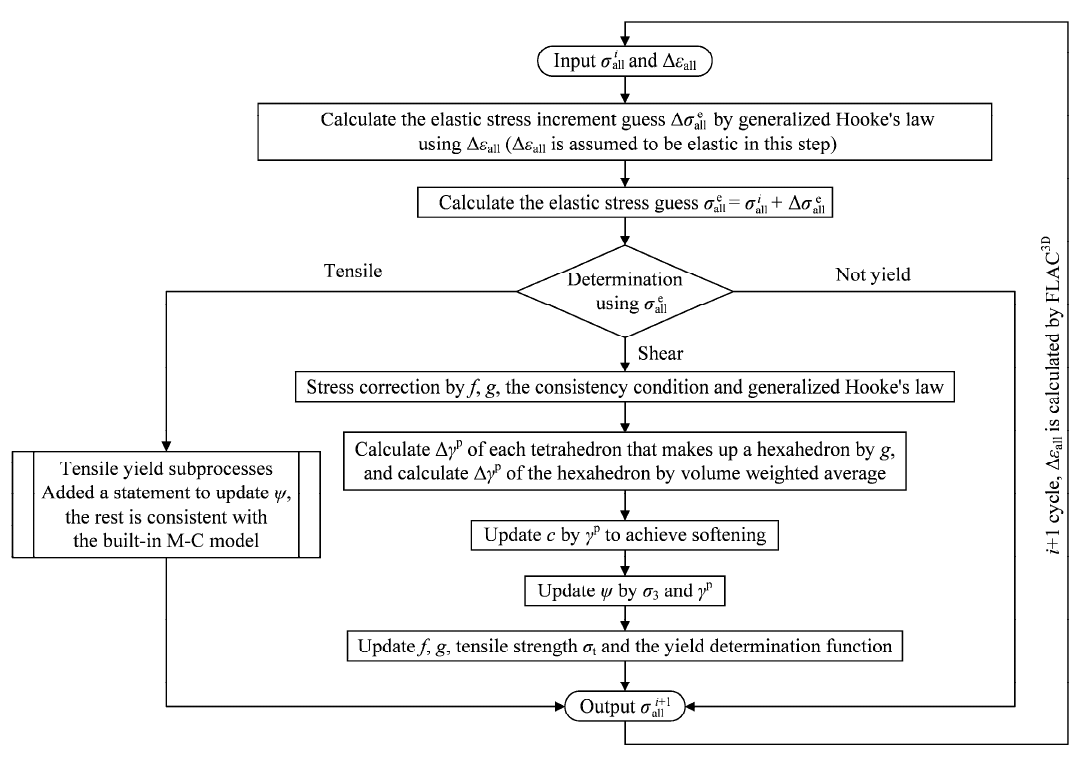
Figure 5. Main calculation steps of the constitutive model.